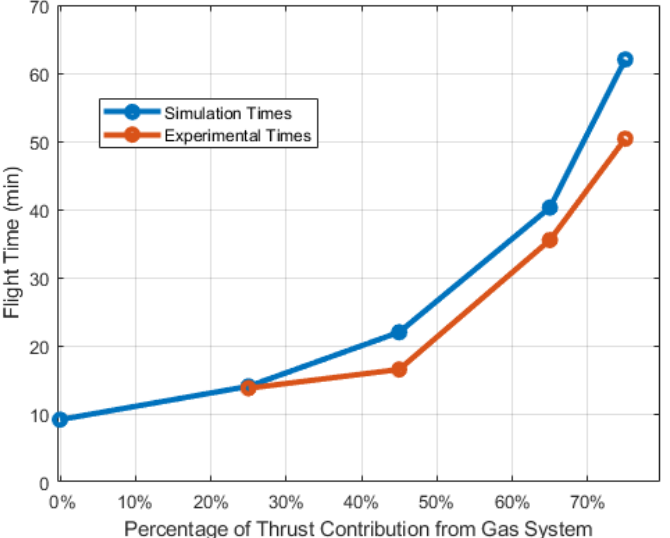
Figure 22. Comparison of simulated and experimental flight times. The experimental times were performed on a test stand to enforce ideal hovering